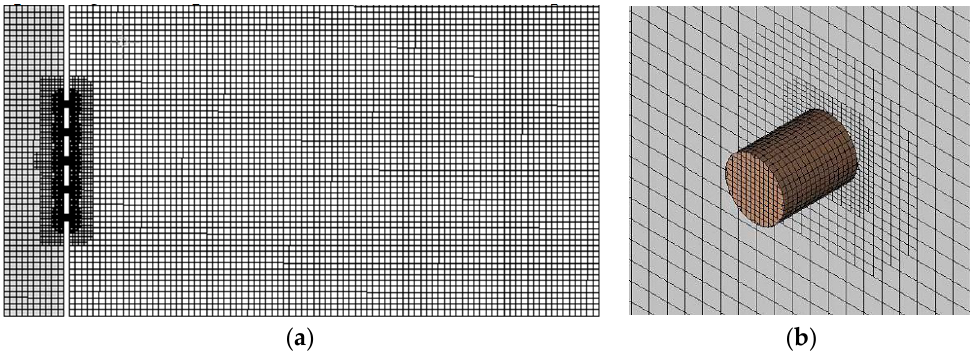
Figure 5. Grid resolution in an impedance tube configured with plate No. 7 absorber: ( a ) grid resolution in the test rig and ( b ) grid resolution in the hole (Hole Diameter = 2 mm).